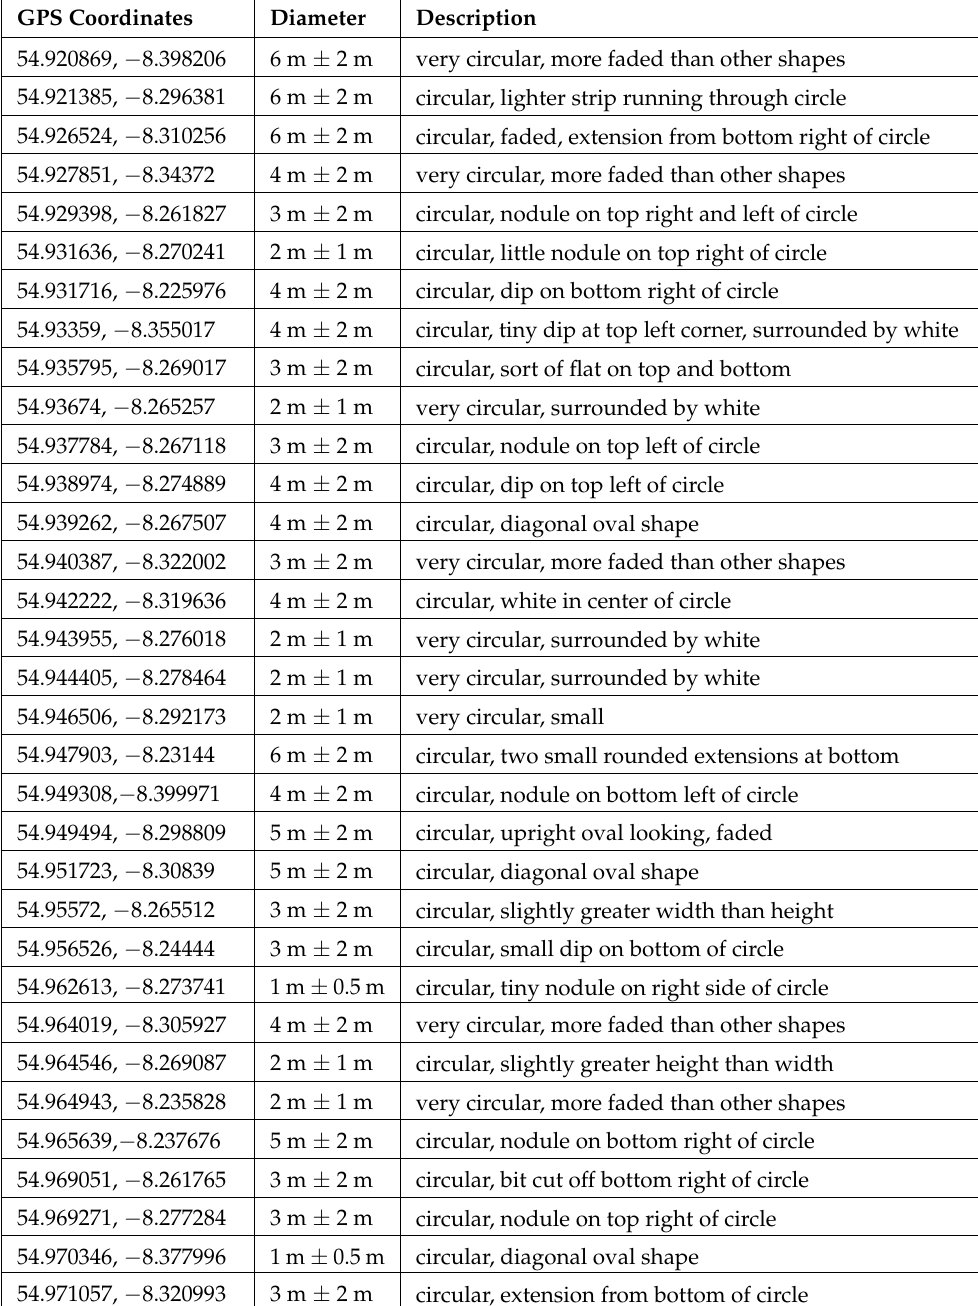
Table A1. Coordinates and description of deformations in peat-bog